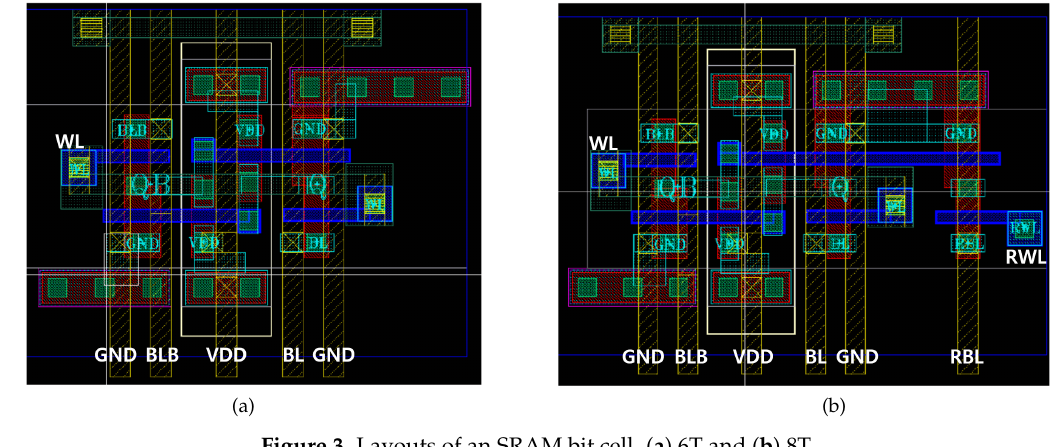
Figure 3. Layouts of an SRAM bit cell. ( a ) 6T and ( b ) 8T.